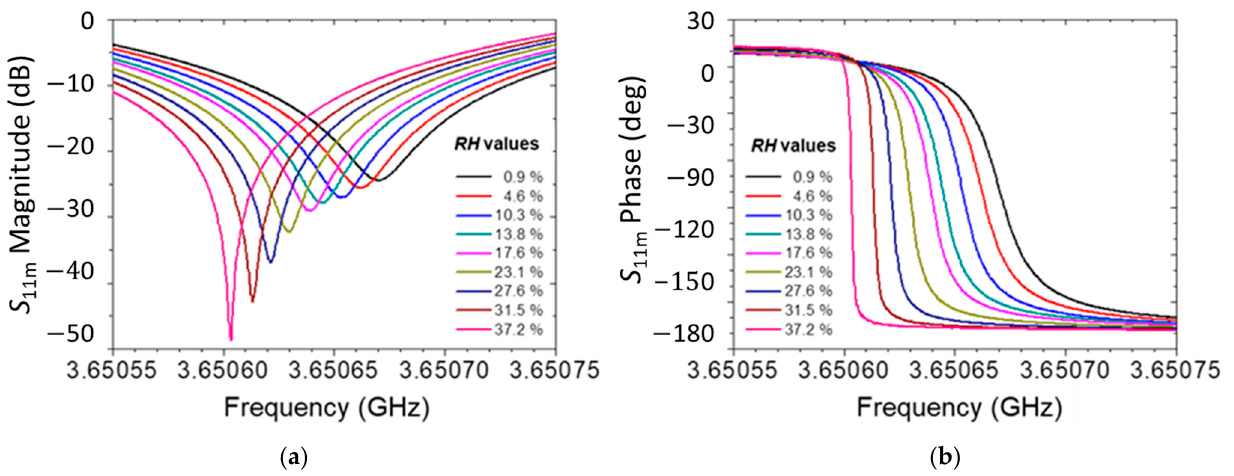
Figure A3. S 11,m magnitude ( a ) and phase ( b ) as function of frequency for RH varying from 0.9% up to 37.2%.